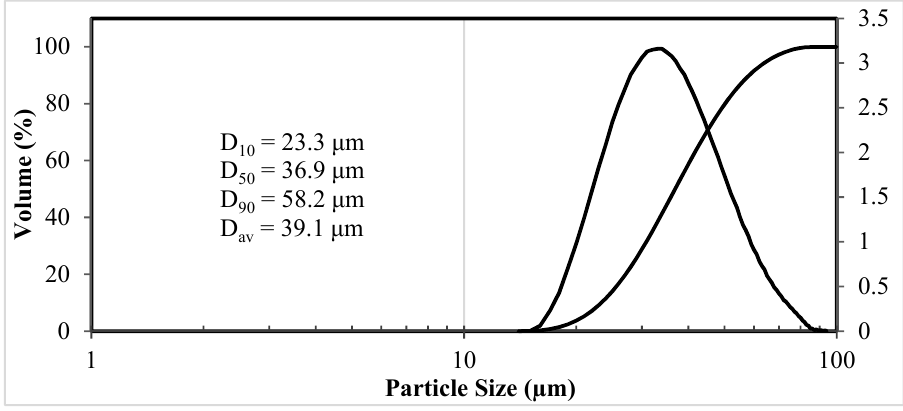
Figure 5. Differential and integral microgranules size.